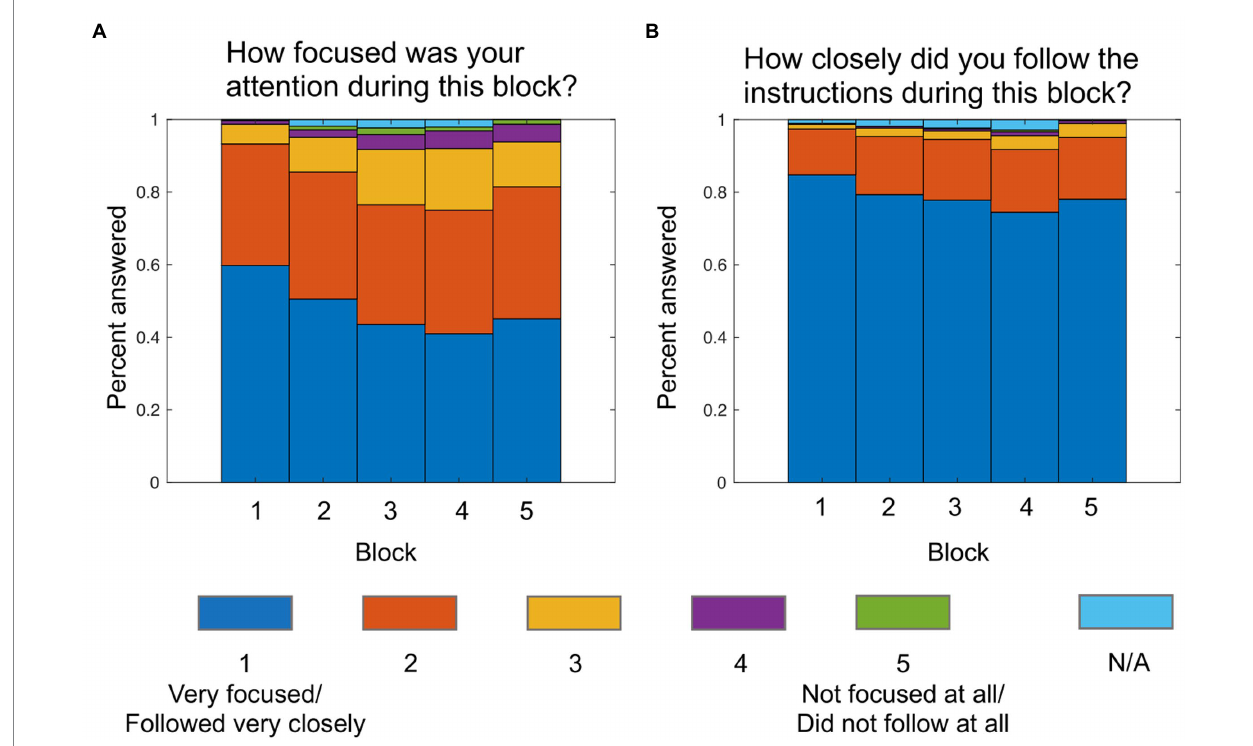
(Figure 6A). Performance in both the Irregularity ( Med =